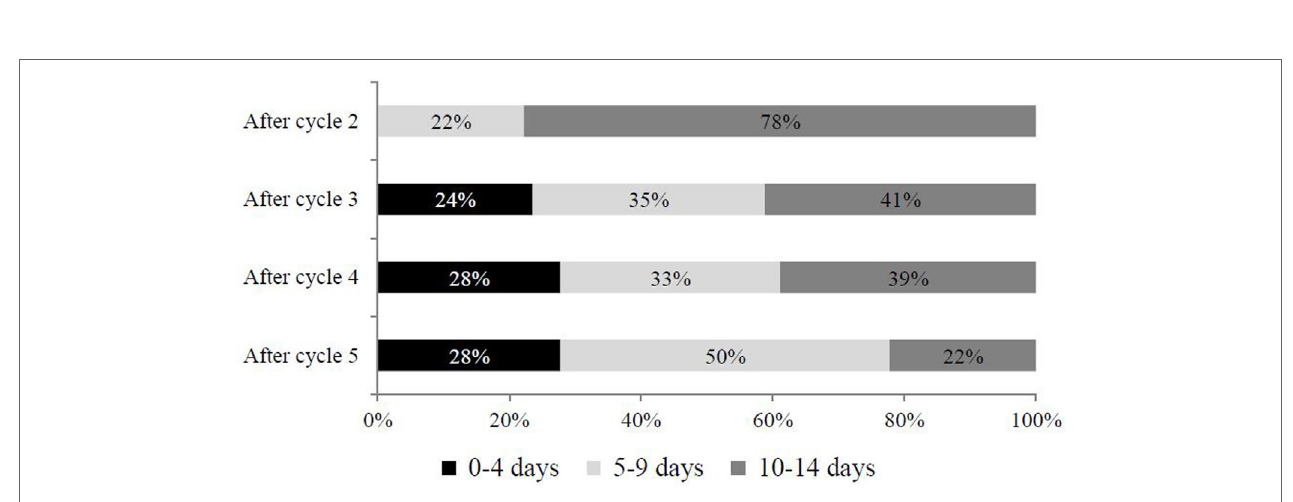
FigUre 3 | Conversion rate from chronic to episodic migraine (EM) across treatment cycles. Chronic: chronic migraine according to ICHD-III beta criteria (3); episodic: EM according to ICHD-III beta criteria